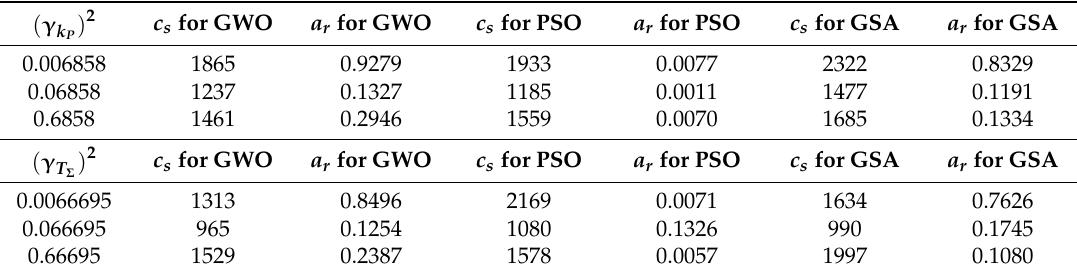
Table 3. Average values of c s and a r